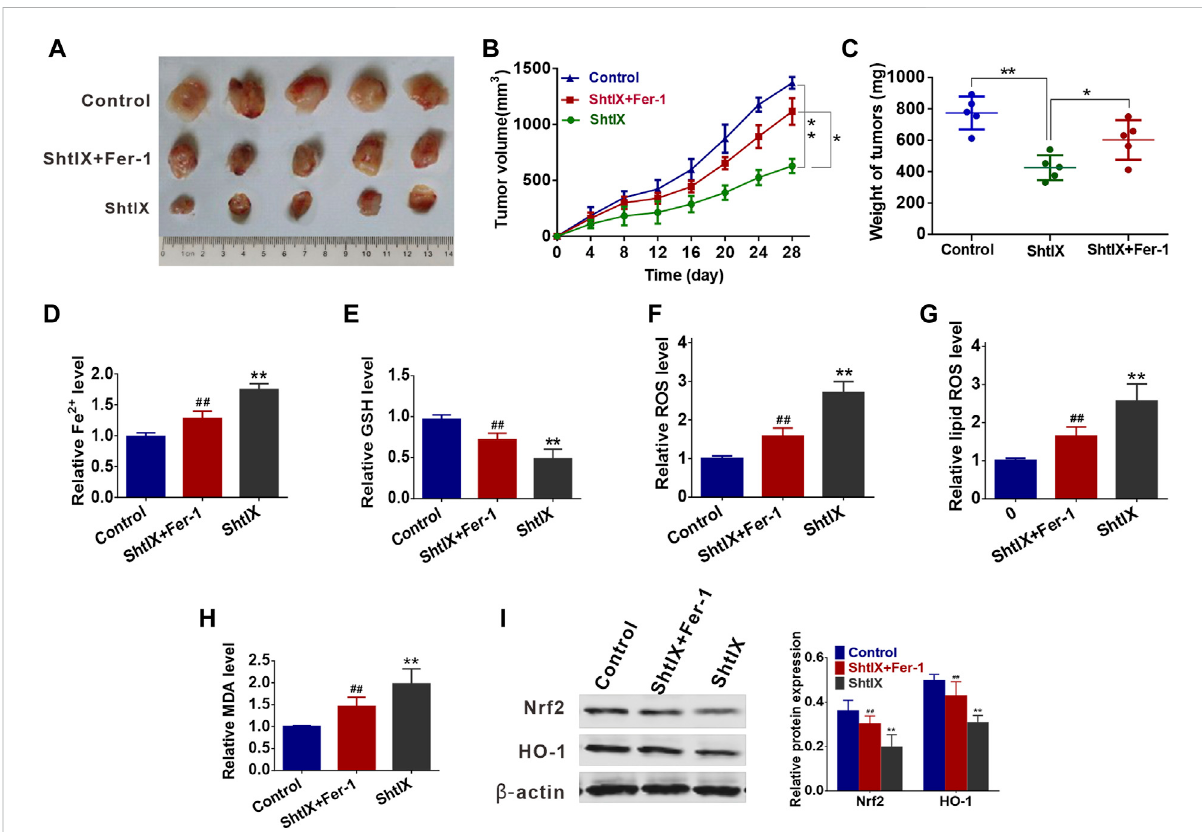
FIGURE 7 ShtIX retards tumor growth and induced ferroptosis in vivo . (A) The images of tumors dissected from mice. (B) Xenograft tumor volumes were detectedevery3 daysfor28 days. (C) Xenografttumorweightsweremeasured. (D – I) ThelevelsofFe 2+ ,GSH,ROS,lipidROS,MDA,Nrf2andHO-1in tumor tissues were analyzed. * p < 0.05, ** p < 0.01, # p < 0.05, ## p <